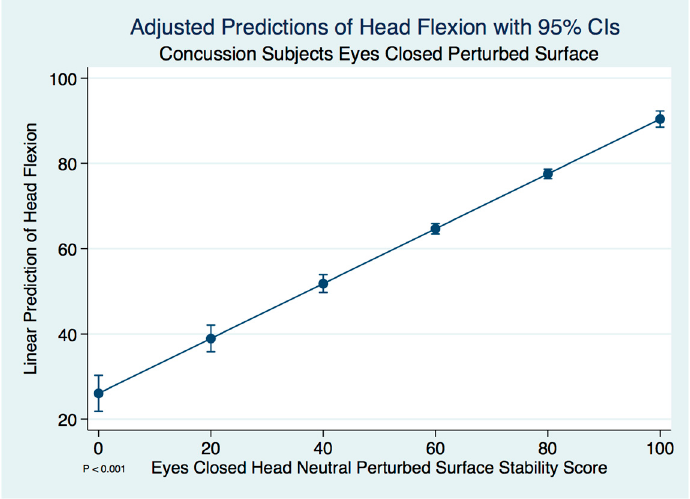
Figure 5. Adjusted predictions of head flexion stability scores in concussion subjects.